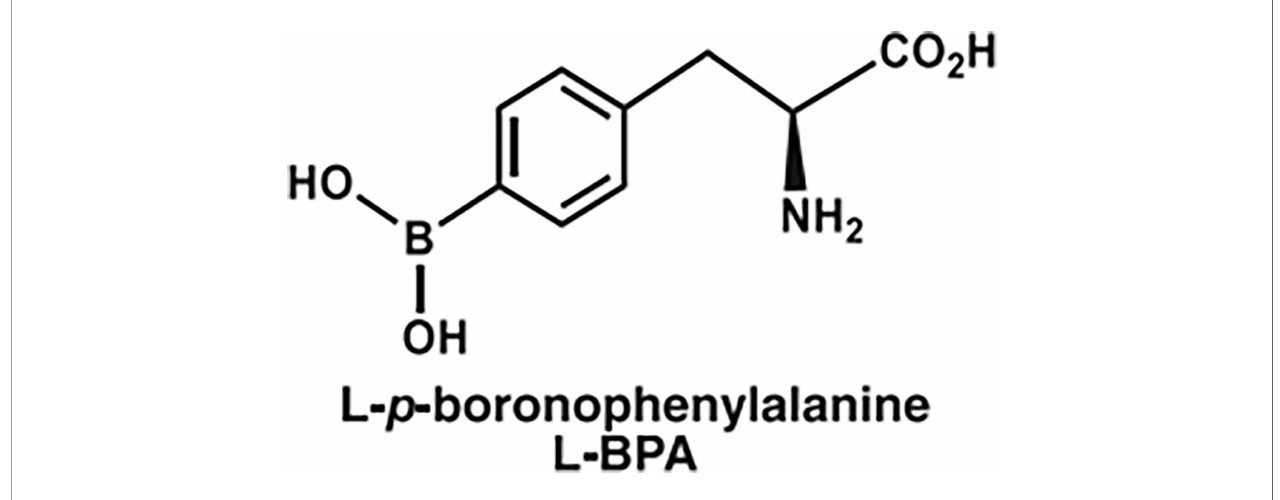
FIGURE 1 | Structure of